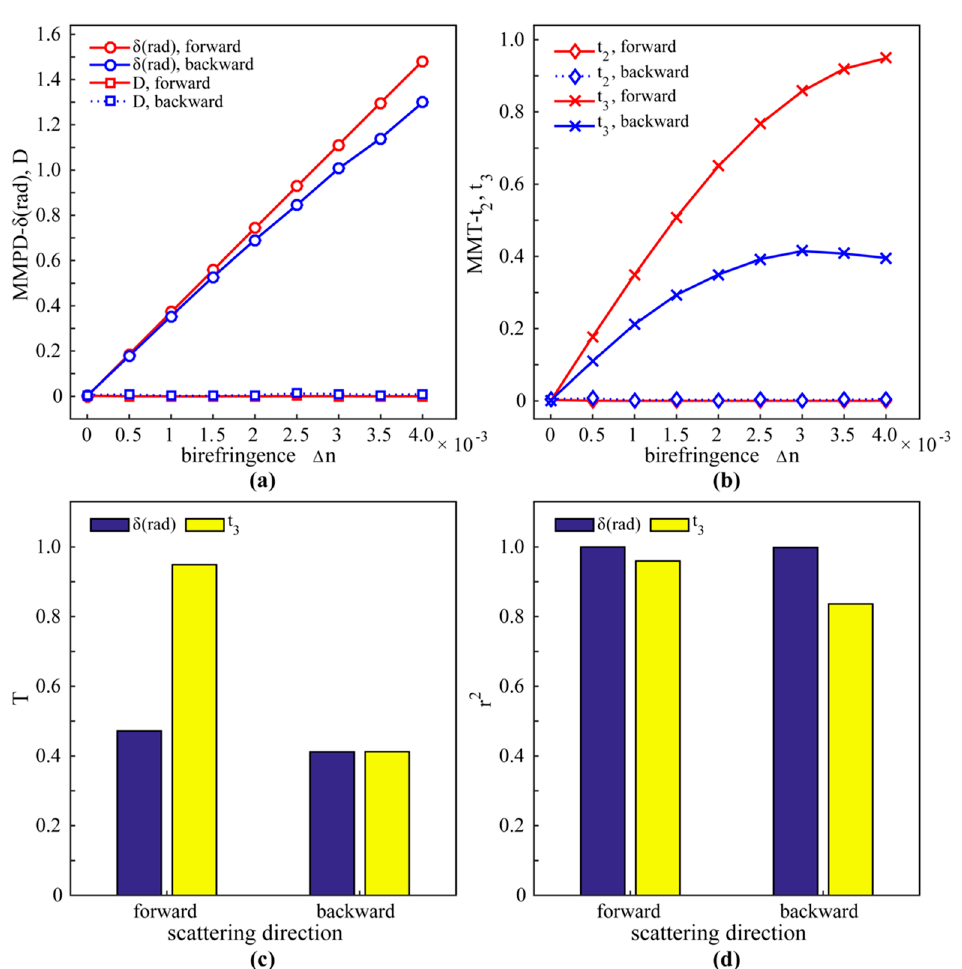
Figure 6. MC simulation results of a sphere-birefringence model in both forward and backward scattering directions: ( a ) MMPD parameters D and δ . ( b ) MMT parameter t 2 and t 3 . ( c ) T of δ and t 3 ;